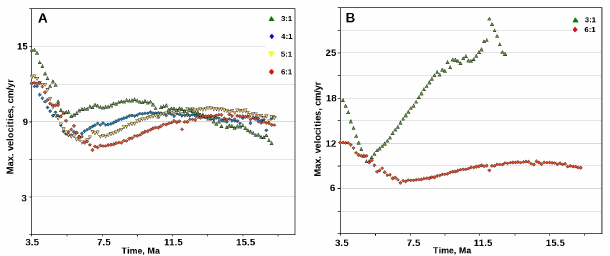
Fig. A3. (A) Maximum velocities for model with aspect ratio 6:1, and scaled maximum velocities for models with 3:1, 4:1 and 5:1 as- pect ratios. (B) Comparison of maximum velocities for two models without applying the velocity scaling